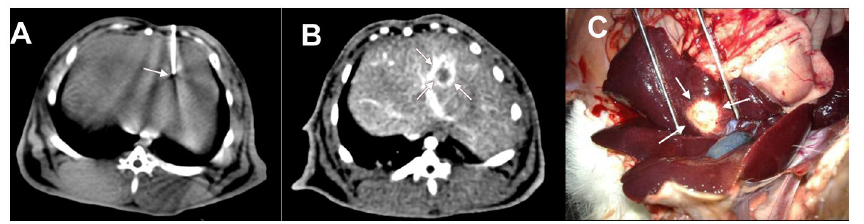
Figure 1. Tumor implantation, CT scans and macroscopic appearance of an individual rabbit of the cell suspension group. A shows tumor implantation under CT guidance and transplantation site (white arrow); B shows the tumor on contrast- enhanced CT scan (white arrow) on day 14; C shows a single tumor in the left medial lobe of liver during dissection on day 32 after implantation (white